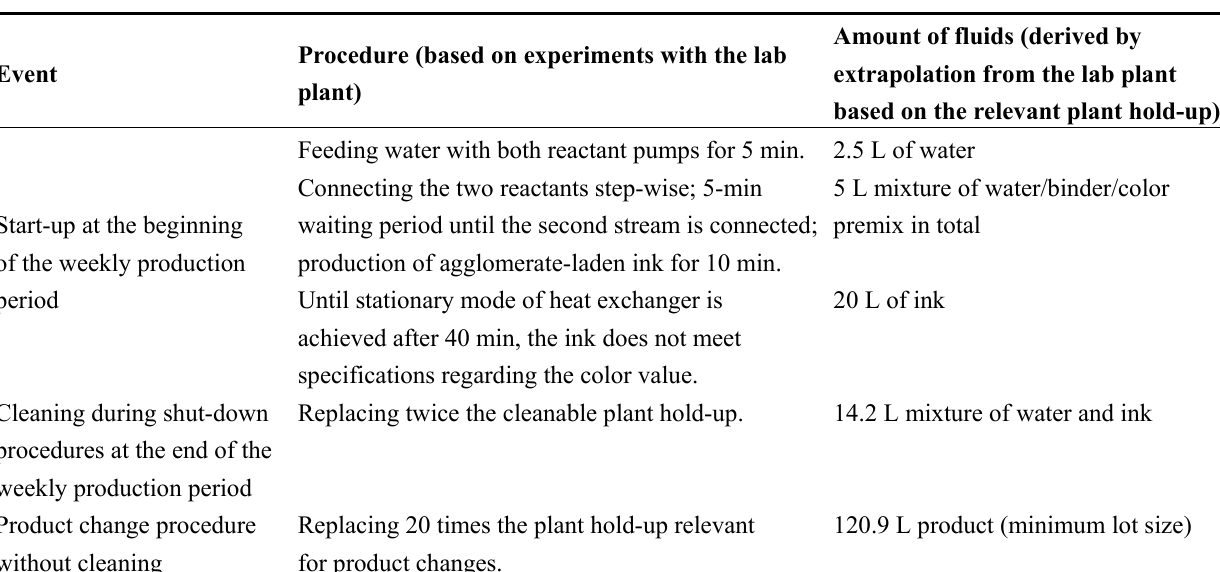
Table 1. The procedures and amount of fluids to be considered during start-up, shut-down and product change for the drafted continuous multi-product production plant at a volumetric flow rate of 30 L h − 1